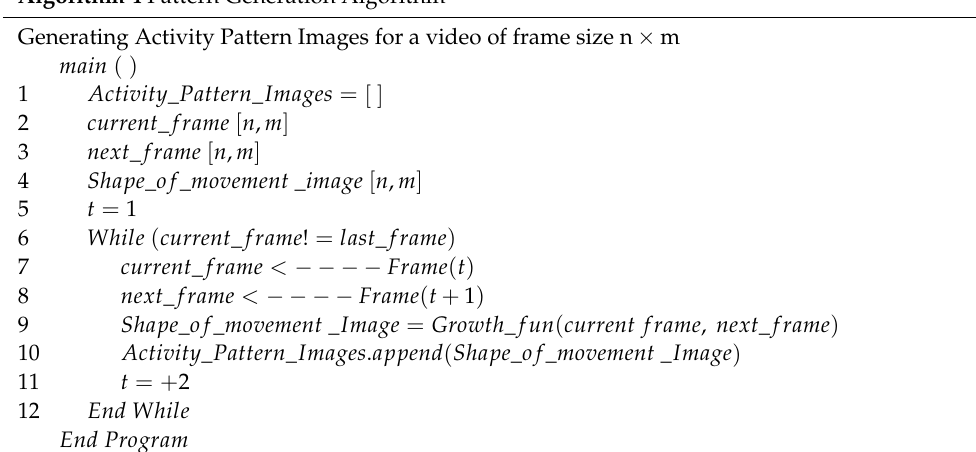
Algorithm 4 Pattern Generation